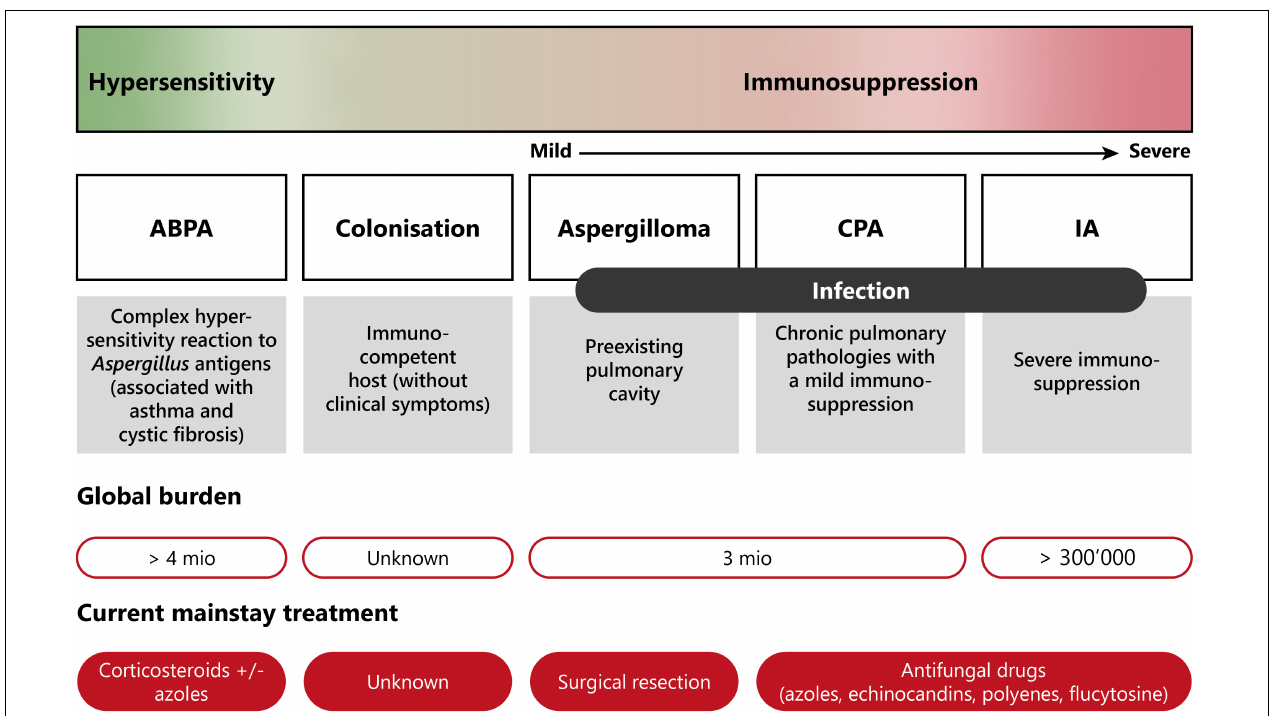
FIGURE 2 | Disease spectrum of pulmonary aspergillosis. This diagram summarizes the diverse pathologies caused by Aspergillus spp., due to improper elimination of conidia by mucociliary clearance or macrophage phagocytosis following inhalation. Depending on the immune status of the host, pulmonary aspergillosis can range from allergic reaction (hypersensitivity) to life-threatening invasive infection (severe immunosuppression). Moreover, current burden and treatment information are indicated. ABPA, allergic bronchopulmonary aspergillosis; CPA, chronic pulmonary aspergillosis; IA, invasive aspergillosis. Modified from Palmieri